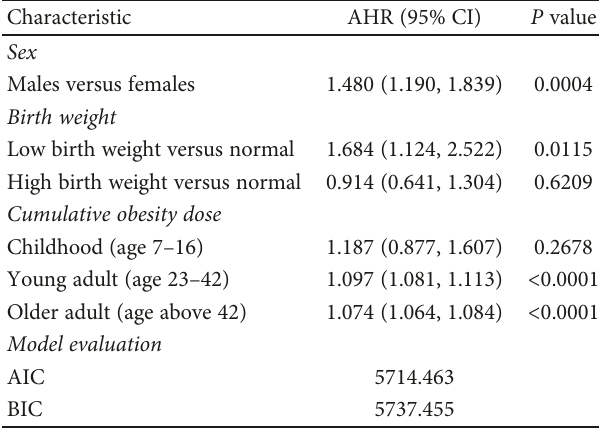
Table 5: Interaction between cumulative obesity dose and age groups in risk for